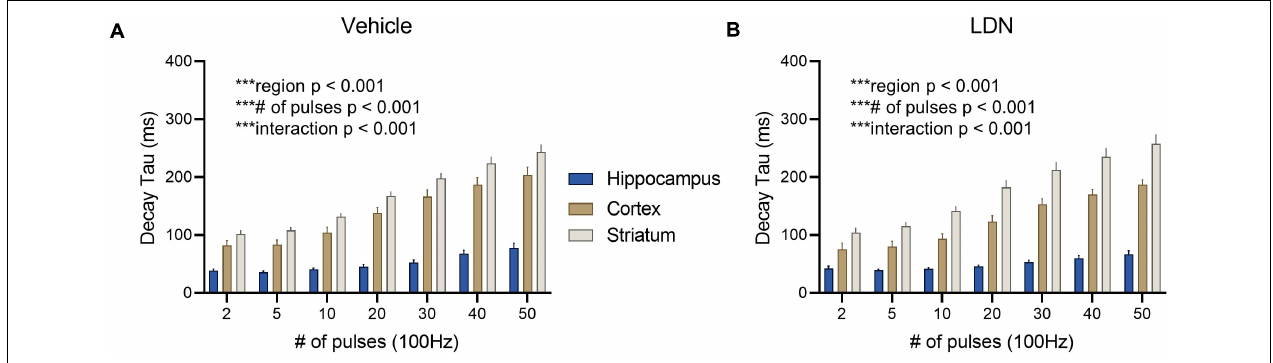
FIGURE 8 | The effect of LDN on regional differences in glutamate clearance. (A) Mean ( ± S.E.M) iGluSnFR decay tau values to compare regional differences in glutamate clearance in vehicle-treated mice. (B) Mean ( ± S.E.M) iGluSnFR decay tau values to compare regional differences in glutamate clearance in LDN-treated mice. *** p <